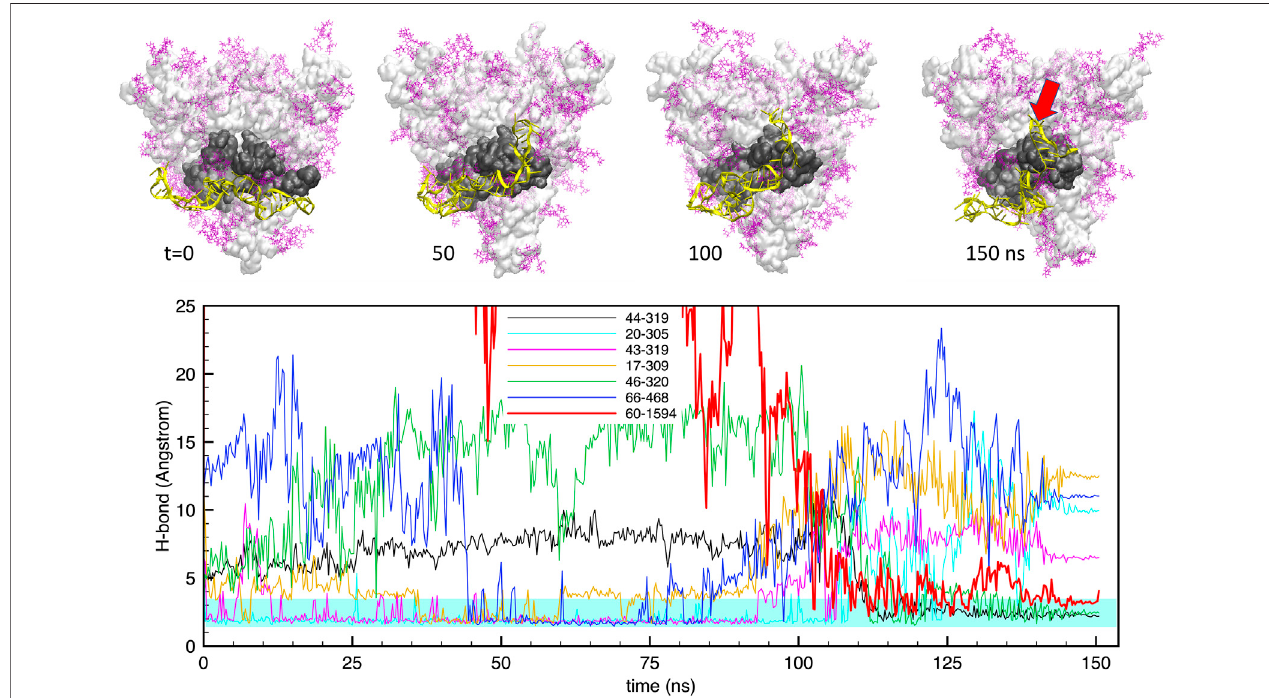
FIGURE4| EvolutionofthestructureandhydrogenbondsformedbytheDNAapta2(67-nt)interactingwiththeS-proteintrimerintheclosedconformation. Lower panel. Time plot of the major H-bonds formed by nucleotides (numbers 1 – 67) and S-protein residues (numbers > 300). Thin lines indicate the H-bonds between the aptamer and the RBD of monomer 1, the thick red line indicates the extra H-bond with the RBD of monomer 2 (setting in at times t > 100 ns The cyan shaded band ̊ ). Upper panel. Snapshots of the aptamer-S-protein contact, at times t (cid:2) 0,50, 100, 150 ns DNA is indicates the typical interval of H-bond length (2.4 – 3.6 A depicted in yellow; protein surface in light grey, with the RBD of monomer one in dark grey; glycans in purple. The red arrow at t (cid:2) 150 indicates the site of the extra H-bond with the RBD of monomer 2. All fi gures with the central axis perpendicular to the plane.